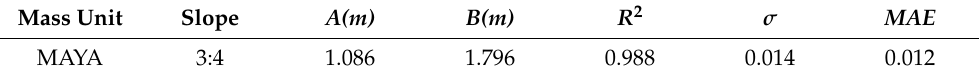
Table 5. New coefficients A ( m ) and B ( m ) to be included in Equation (3) refitted exploiting the experimental data. Best fit values R 2 , σ , and MAE are also reported.